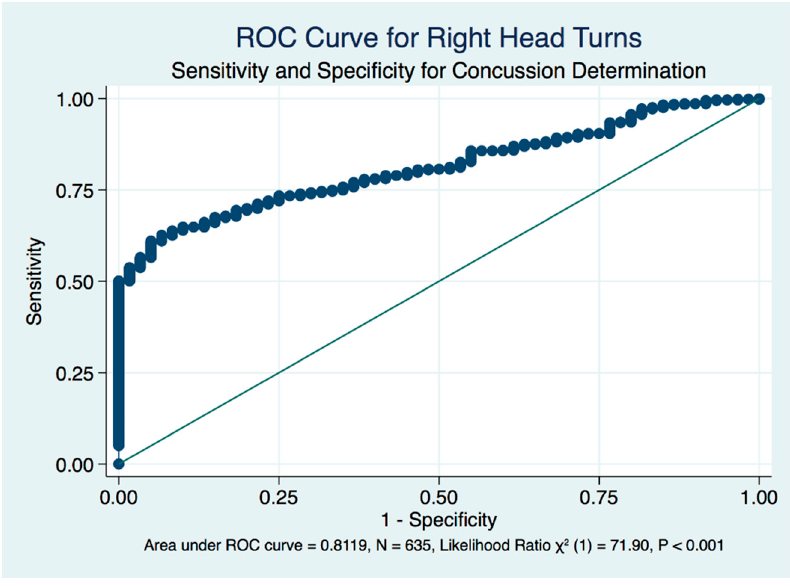
Figure 10. ROC curve for right head turn, eyes closed perturbed testing in concussion determination.